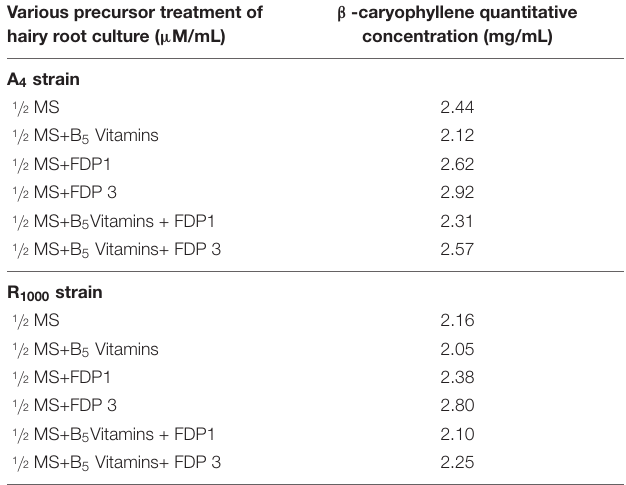
TABLE 3 | Different concentration of with and without precursor treated callus samples quantified by GC-MS. Various precursor treatment of calli